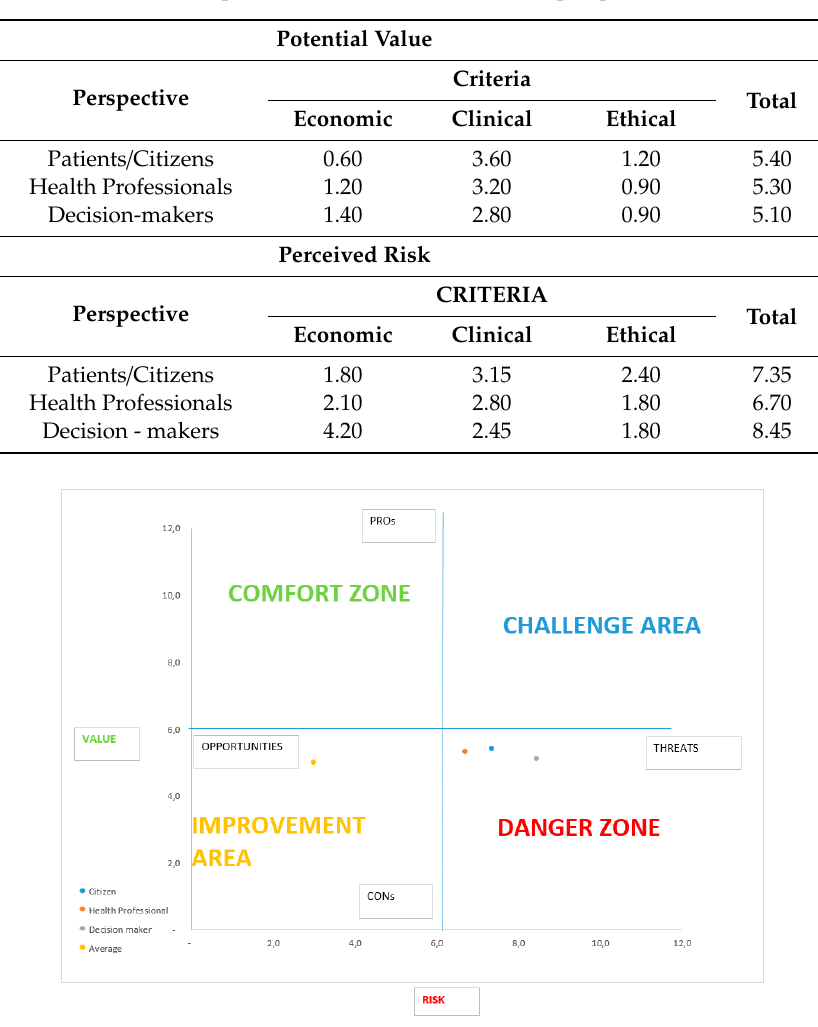
Table 3. Individual protection device: scores for each perspective and criteria.